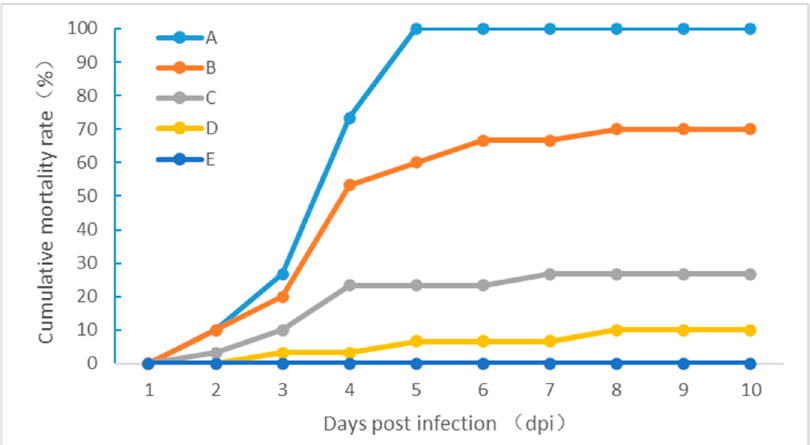
Figure 6. The pathogenicity of the isolate ZZ051 in healthy channel catfish experimentally infected with ( A ) 1 × 10 6 , ( B ) 1 × 10 5 , ( C ) 1 × 10 4 , and ( D ) 1 × 10 3 CFU/fish. ( E ) Negative control.